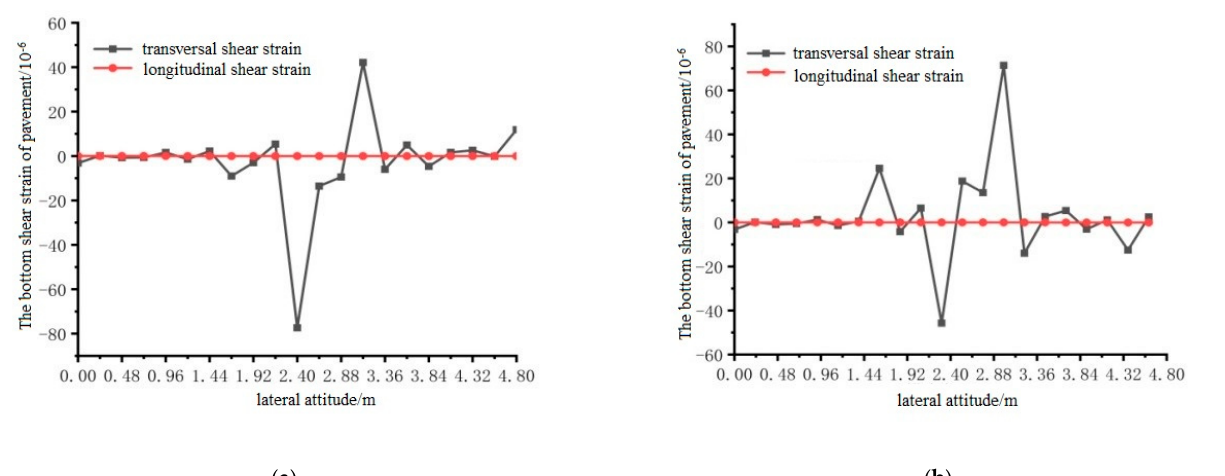
Figure 35. The transverse distribution of longitudinal and transverse shear strain on the surface of